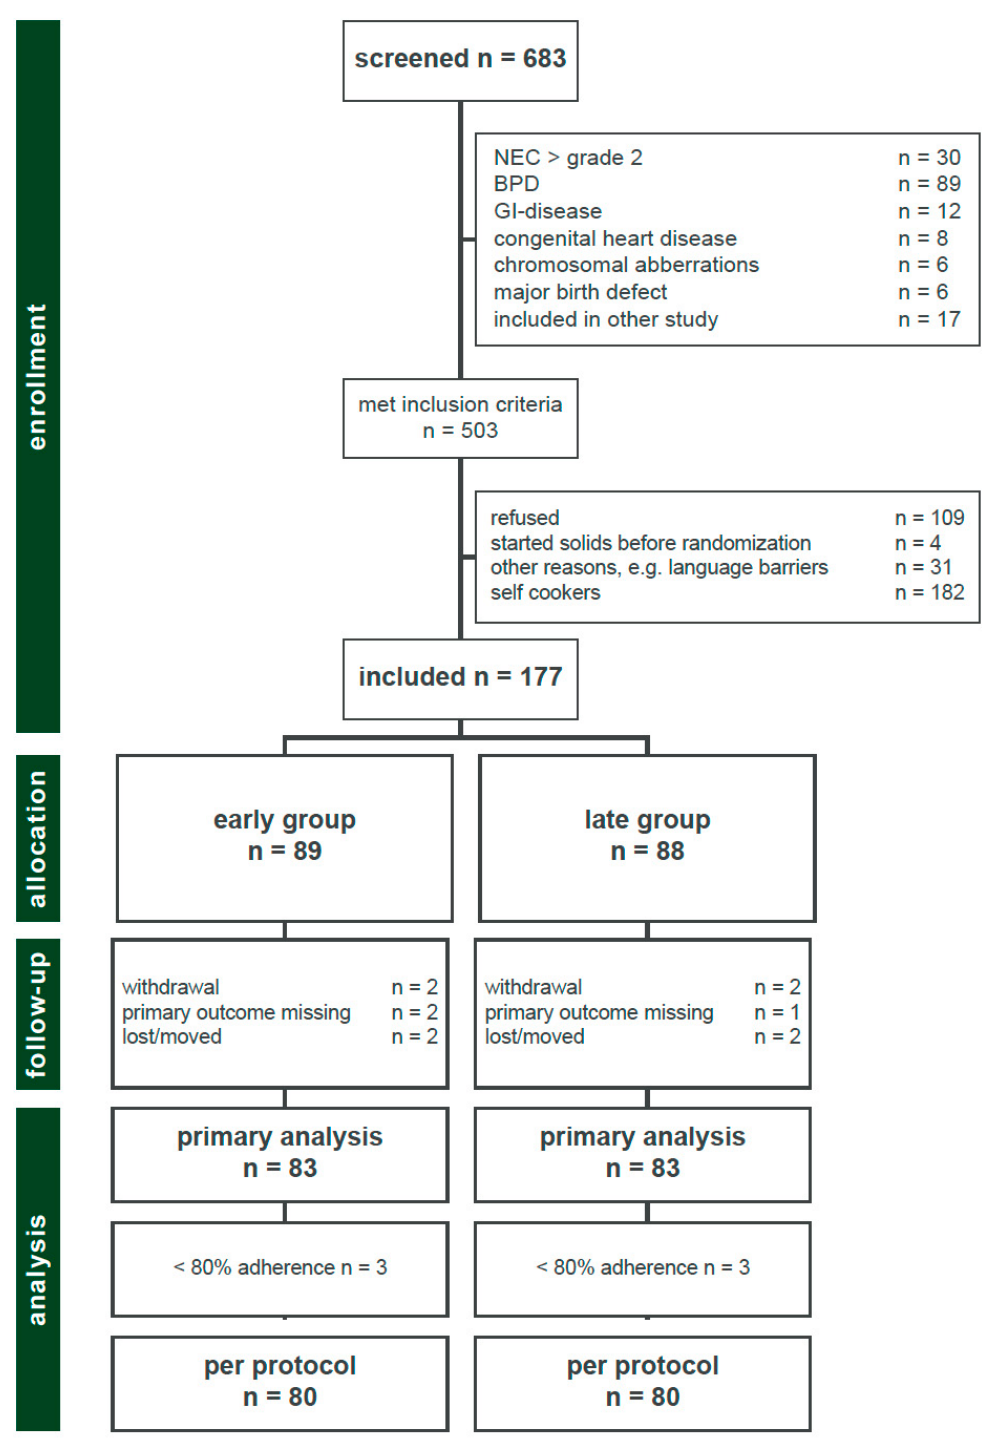
Figure 1. Trial Figure 1. Trial profile.